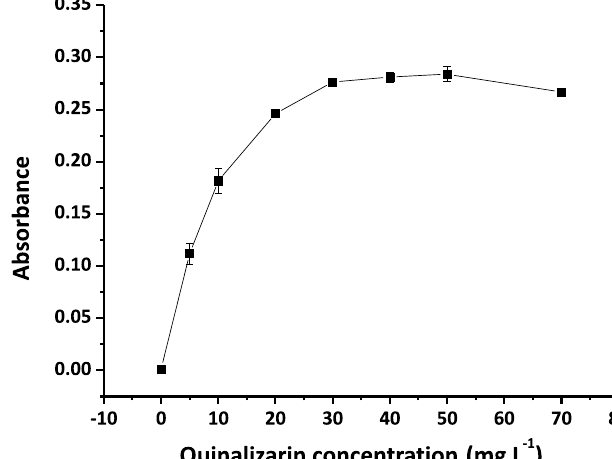
FIGURE 5 - Study of the effect of quinalizarin concentrations on the analytical signal. Experimental conditions: rosuvastatin: 20 mg L -1 in DMSO: 75%